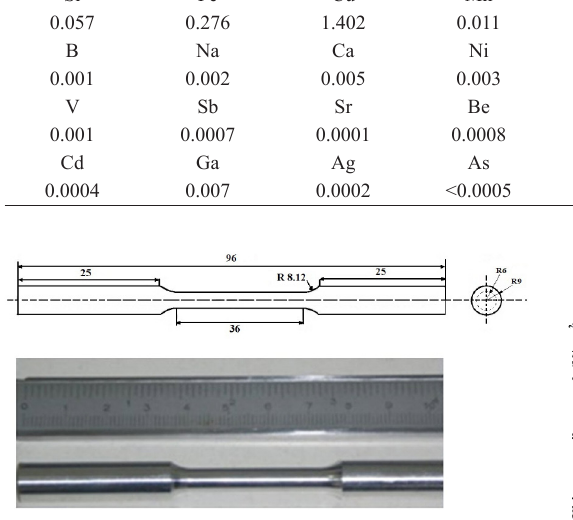
Figure 1. The tensile test sample.